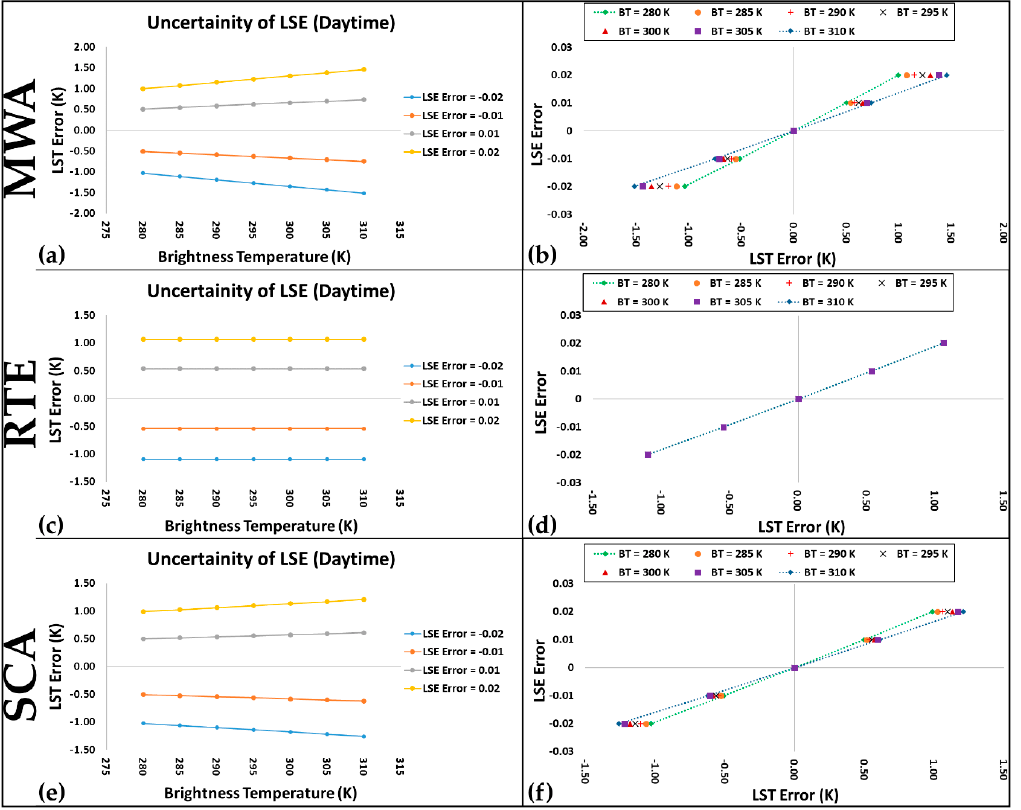
Figure 3. Sensitivity results of Mono Window Algorithm (MWA) ( a , b ), Radiative Transfer Equation (RTE) ( c , d ), and Single Channel Algorithm (SCA) ( e , f ) to LSE for daytime Landsat 8 images. LST error is computed as in Equation (16).